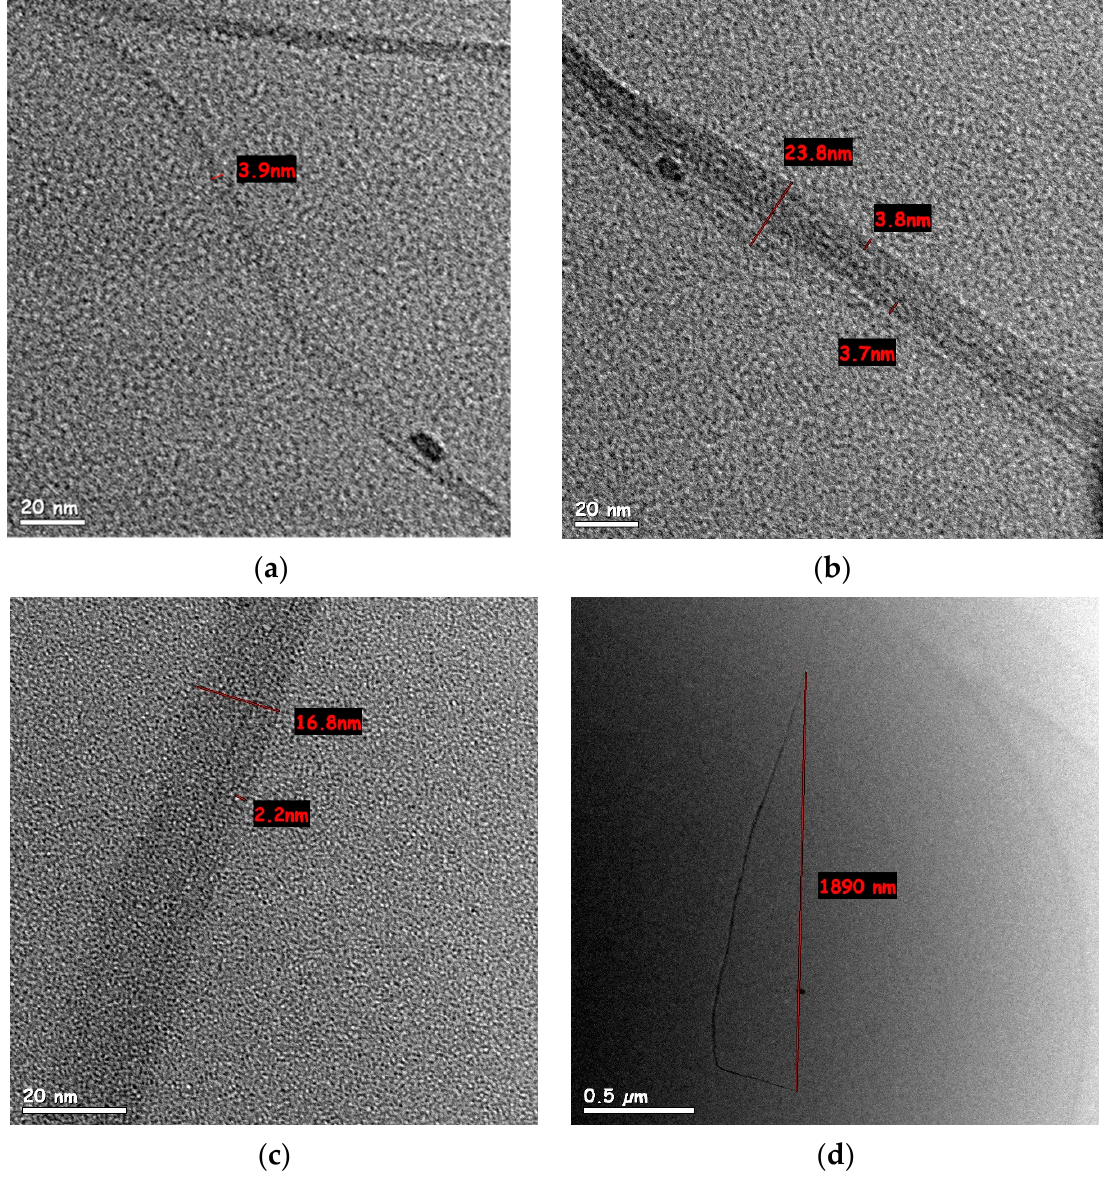
Figure 3. HR-TEM images of different bundles size for SWCNT in water-based dispersion after 218 Wh: ( a ) bundle split, one of the sections is of 3.9 nm diameter, containing 2–3 tubes (scale bar 20 nm); ( b ) 23.8 nm bundle (scale bar 20 nm); ( c ) 16.8 nm SWCNT bundle after 600 Wh dispersion (scale bar 20 nm); ( d ) a low magnification TEM image of SWCNT bundle after 600 Wh dispersion. Its length, measured edge to edge, was approx. 2 µm (scale bar 0.5 µm).